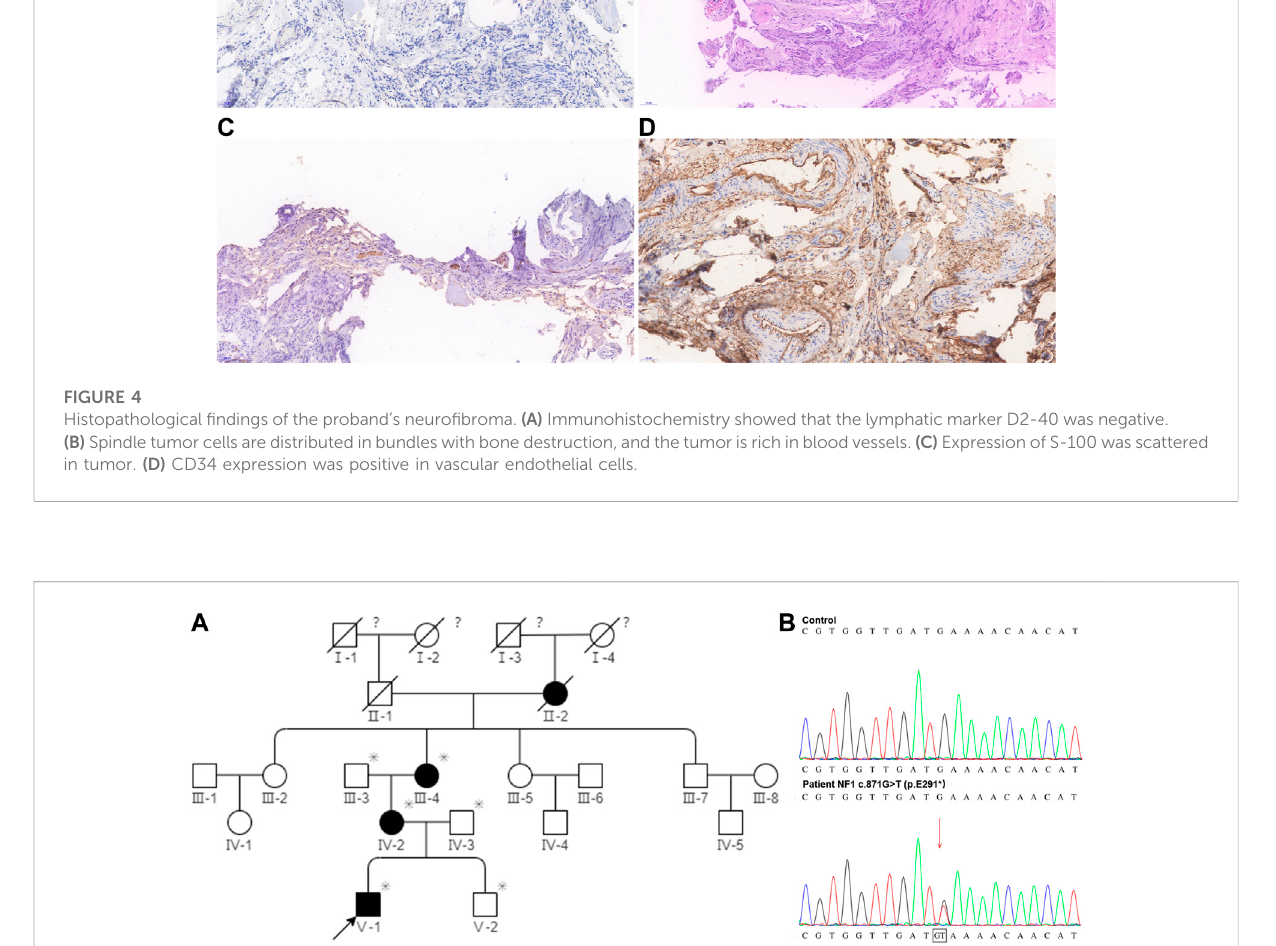
FIGURE 5 Pedigree of the CPT NF1 patient ’ s family and Sanger sequencing con fi rmed the mutation of NF1. (A) Segregation analysis of NF1 variants in a pedigree represents an autosomal dominant inheritance pattern. Squares and circles represent males and females, respectively. Closed and open symbols indicate affected members and unaffected subjects. The arrow denotes the proband. Family history was negative for consanguinity. The slash symbol indicates that the subject is deceased. The asterisk shows the individual underwent both clinical and genetic analyses. The questionmarkindicatesthattheophthalmichistoryisnotavailable. (B) Sangersequencingatthemutationsitewithabloodsample.High-throughput sequencing showed a novel de novo truncation mutation of the NF1 gene in the proband was identi fi ed (c.871G > T; p. E291*).